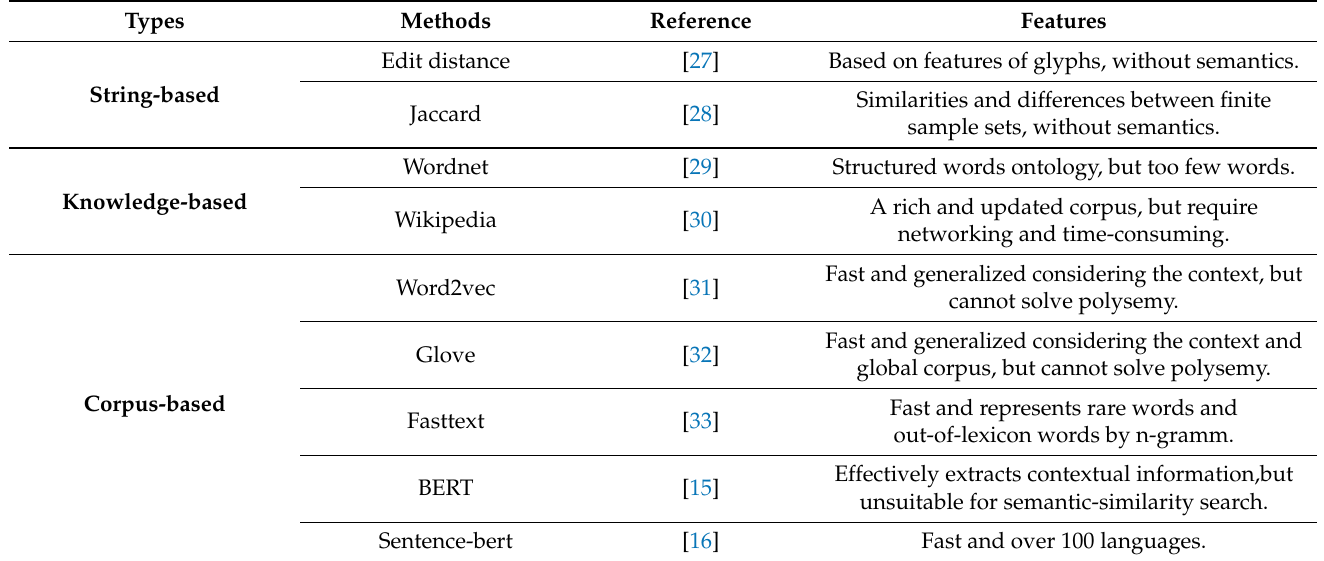
Table 1. Semantic-similarity